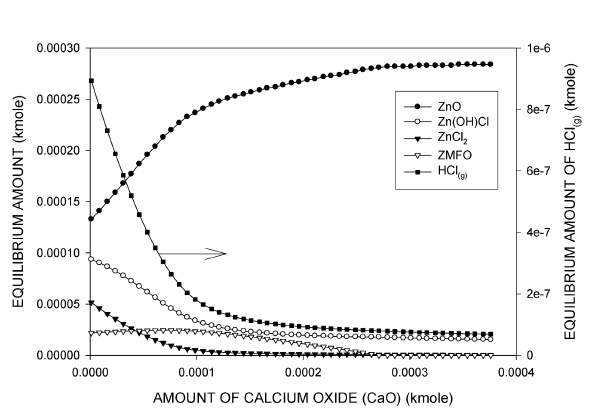
Figure 5(a). Effect of the amount of calcium oxide on the equilibrium amounts of the zinc-containing species for the Zn-Fe-Mn-O-H-C-Cl-Ca system in the absence of CaCO 3 and Ca(OH) 2 .